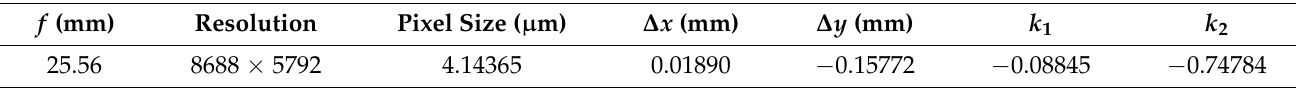
Table 6. Camera parameters of second